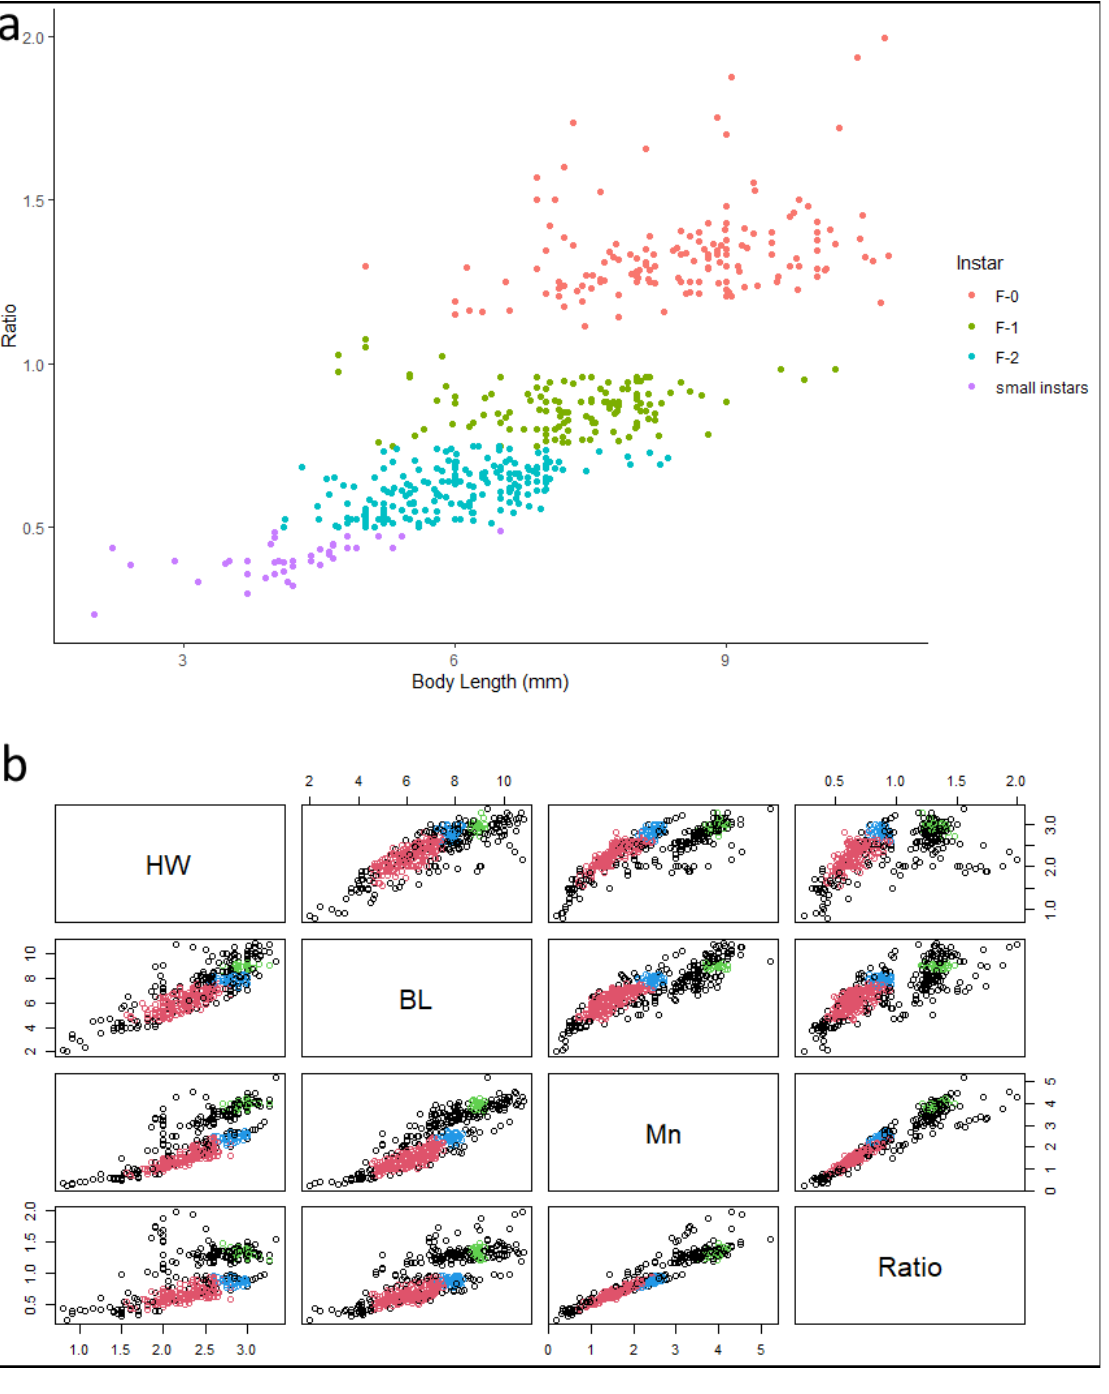
Figure 6. ( a ) Plot of Ratio (mesonotum length + wing pad length (mn + wsl)/head width (HW)) versus body length (BL) showing the assignment of F ‐ 0 (green), F ‐ 1 (blue), and F ‐ 2 (red); ( b ) Multiplot of the DBSCAN clustering indicating three classes (colored dots) corresponding to the last three nymphal instars. BL, HW, and Mn (mn + wsl) units are in mm.